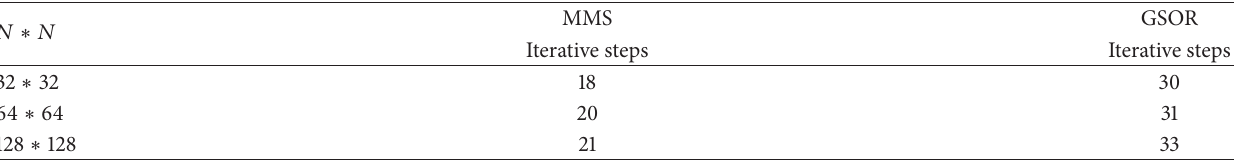
Table 2: Comparison of MMS and GSOR with preconditioned methods ( 𝑀 -matrix).